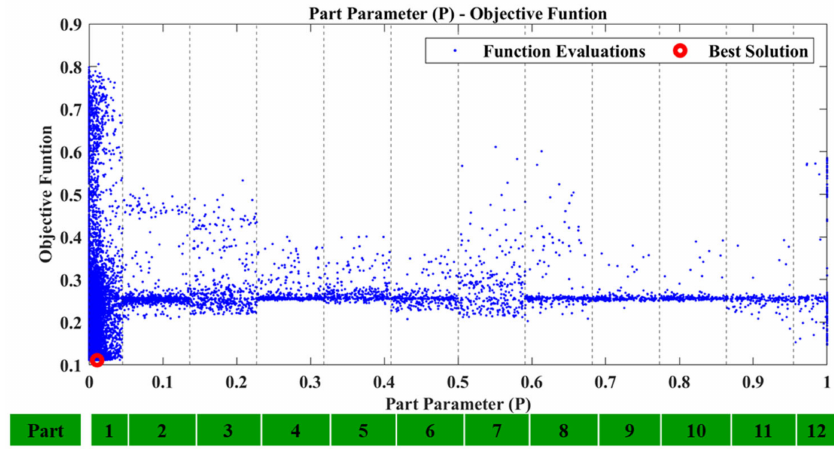
Figure 13. D1: Part parameter (P) versus the Objective Function